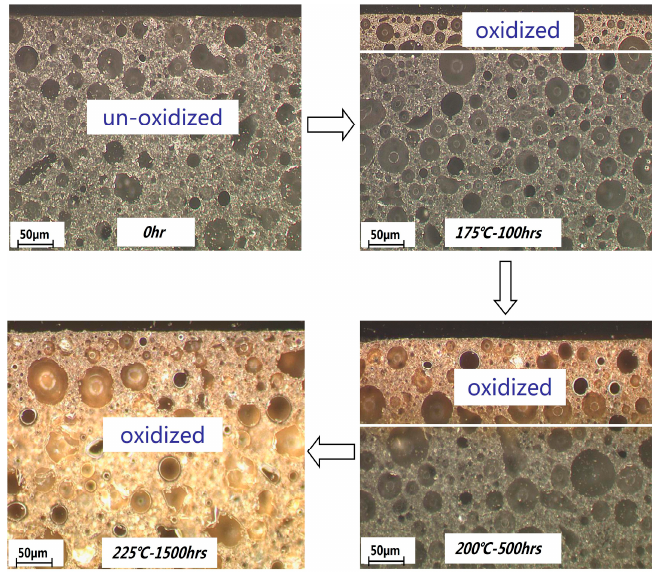
Figure 9. Microscopic images of sample 2 at different aging temperatures and times.